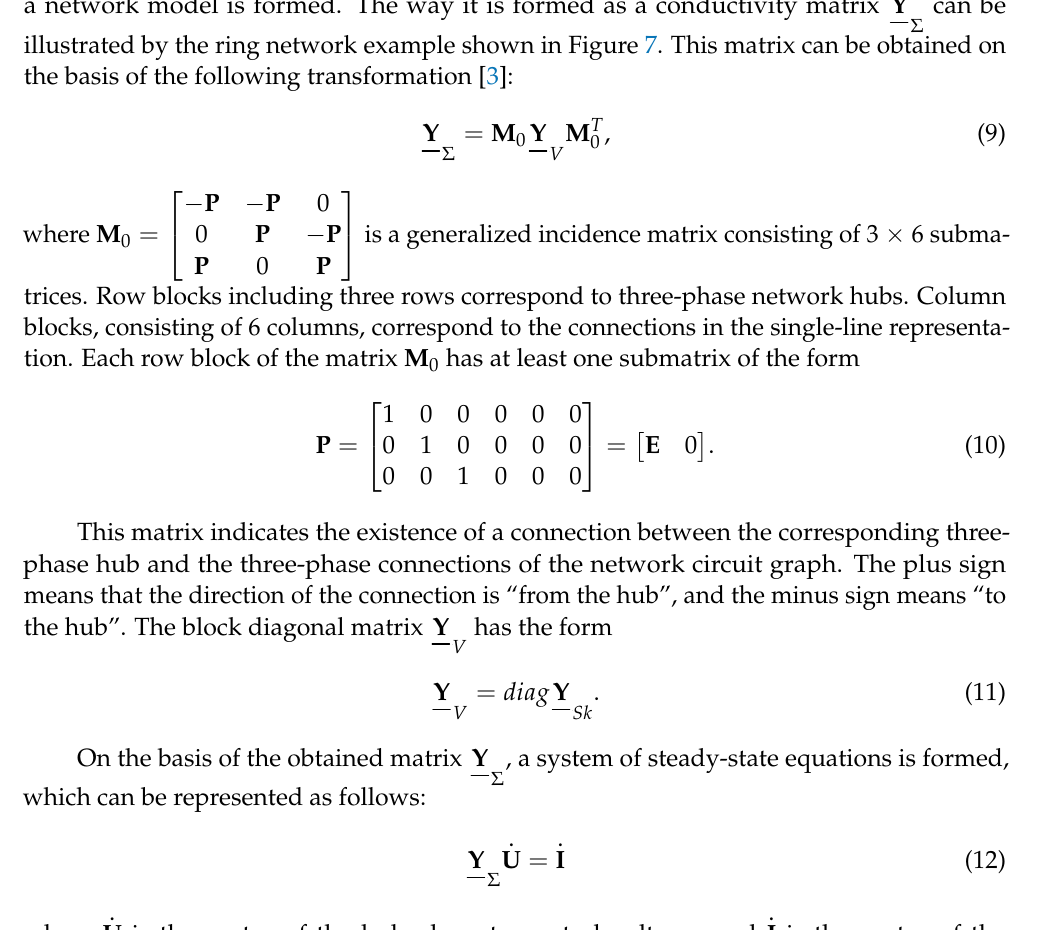
Phase coordinates are the most natural description of three-phase power systems.